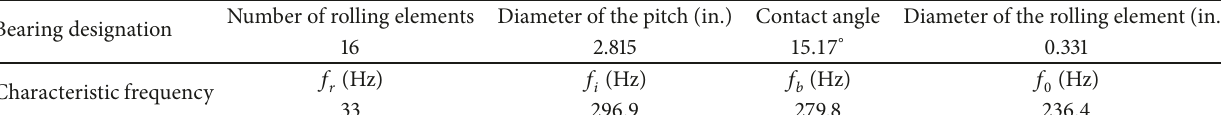
Table 4: Structural parameters and kinematical parameters of the experiment bearing.